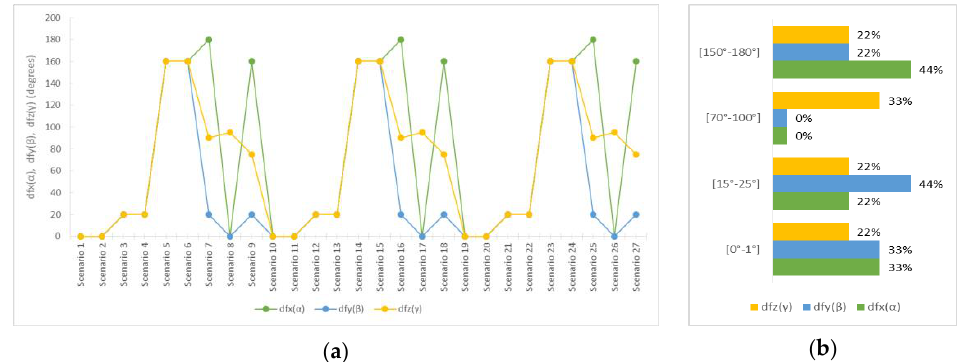
Figure 4. ( a ) Deviations in degrees for rotation angles per axis in the Euler angle method. ( b ) Histogram of deviations for rotation angles per axis in the Euler angle method.